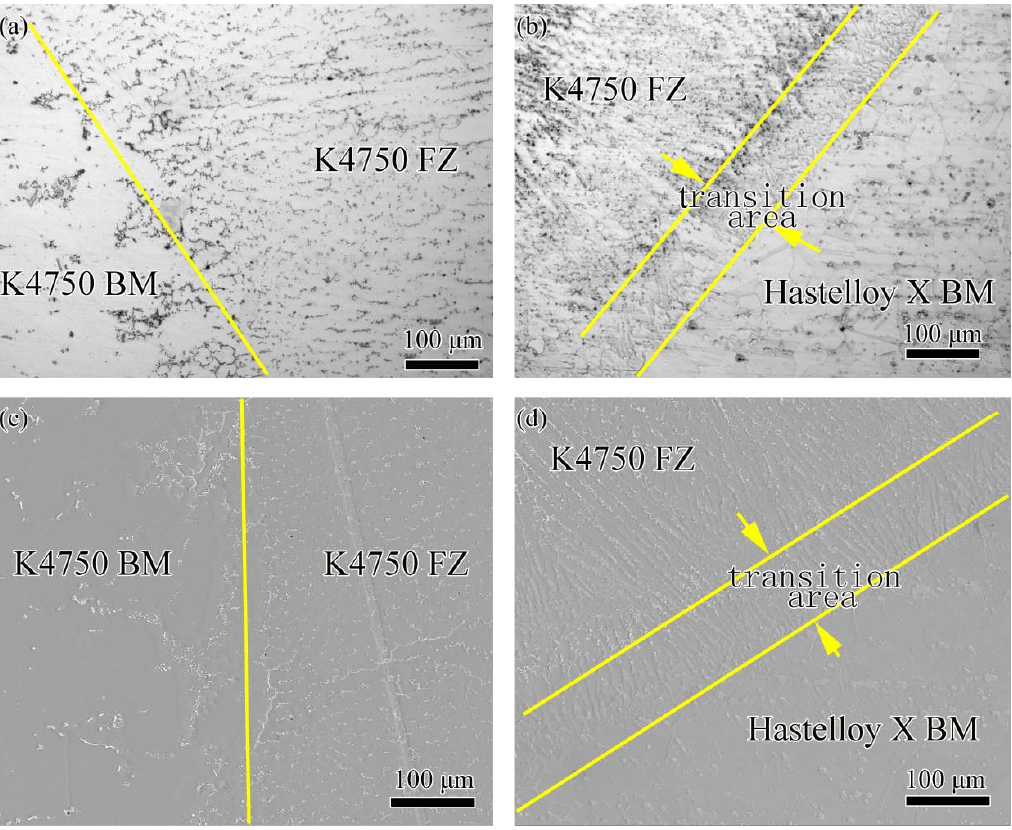
Figure 9. The interfacial characteristics of dissimilar joints with K4750 filler material ( a ) OM image of K4750 (BM) base metal and K4750 (FZ) fusion zone interface; ( b ) OM image of Hastelloy X BM and K4750 FZ interface; ( c ) SEM image of K4750 BM and K4750 FZ interface; and ( d ) SEM image of Hastelloy X BM and k4750 FZ interface.